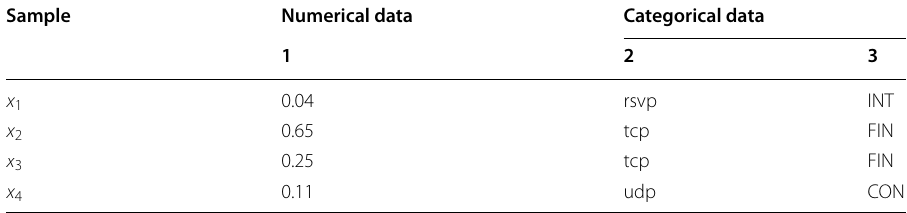
Table 1 The samples we created Sample